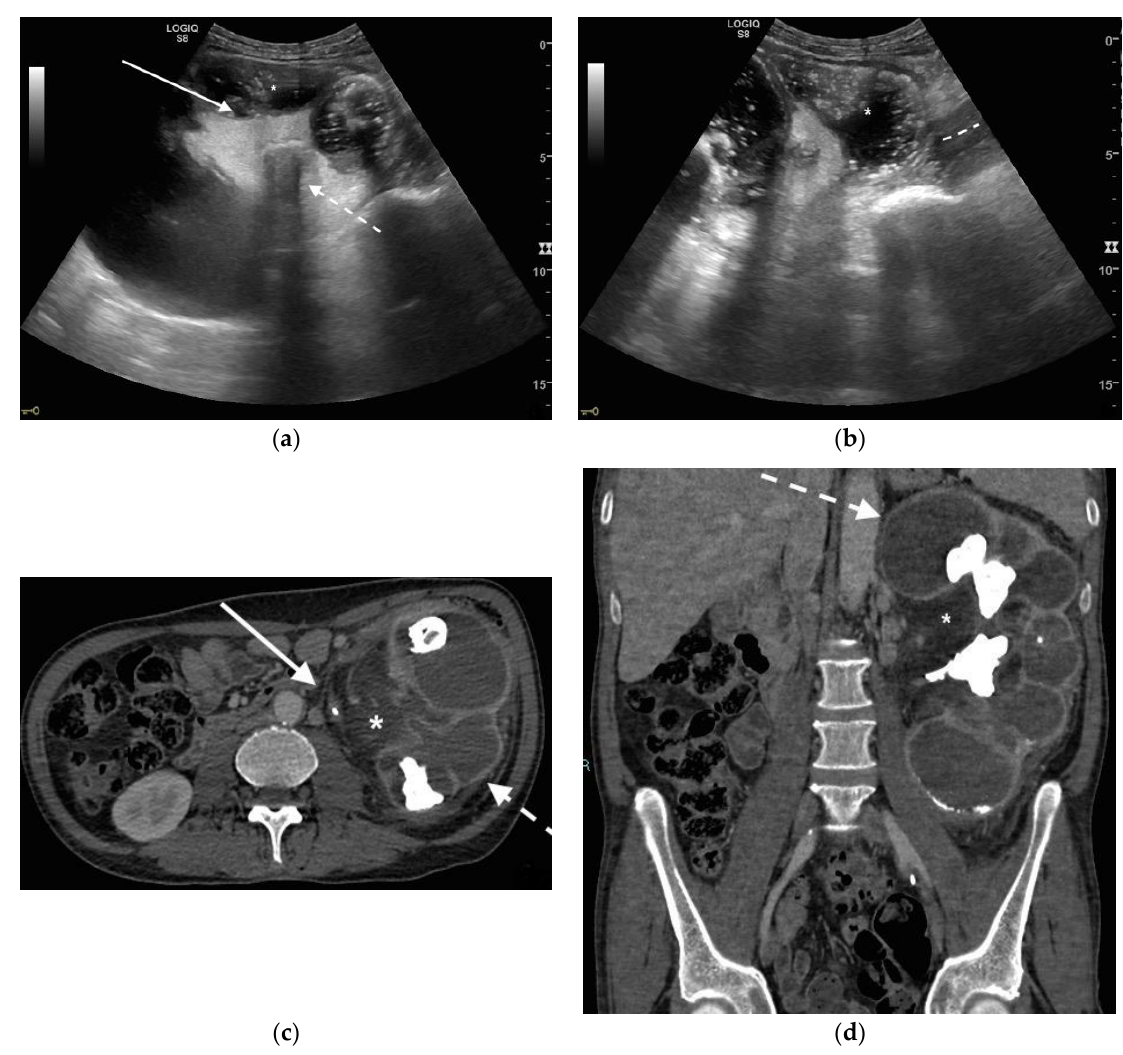
Figure 2. A 71 years old septic patient. US longitudinal ( a , b ) view of left kidney. Severe hydronephrosis, with extreme cortical thinning. High-grade dilatation and parietal thickening (white arrow) of calico-pelvic system fluid filled by inhomogeneous fluid with multiple hyperechogenic spots (*). Enlarged and markedly hyperechogenicity of renal sinus fat with acoustic shadowing due to staghorn calculi (dashed arrow). Perirenal fat inhomogeneity was detected (dashed line). Axial ( c ) and MPR coronal ( d ) CT with intravenous contrast in cortical-medullary phase after stent placement (white arrow), showing high-grade hydronephrosis with diffuse parietal thickening of calico-pelvic system (dashed arrow), staghorn calculi and renal sinus lipomatosis with mild inhomogeneous fat stranding and suffusion (*).